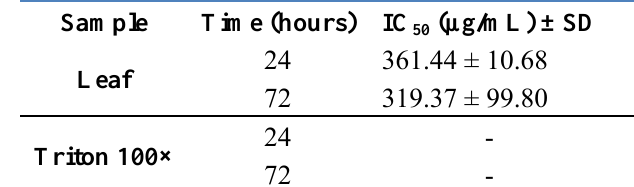
Table 2. The value of IC for Vero cell line after treated with L. camara ’s leaf extract and 50 Triton